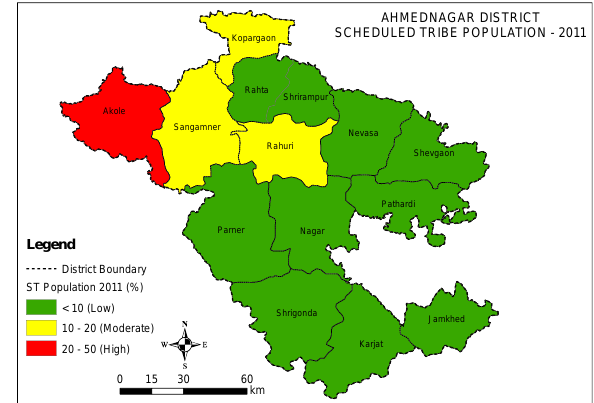
Figure 3. Scheduled Tribe population in Ahmednagar